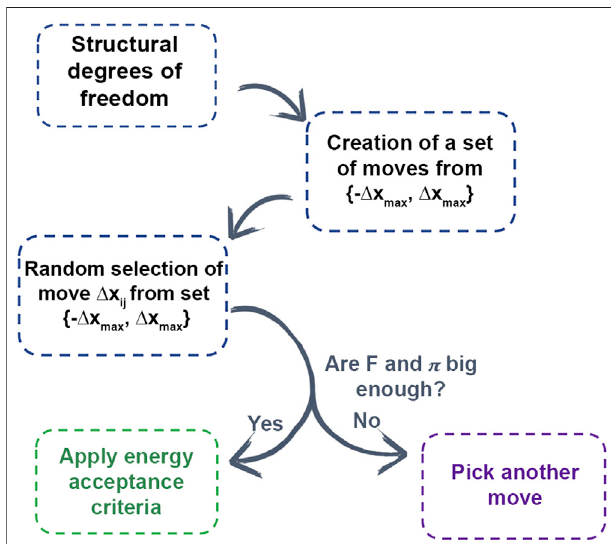
FIGURE 4 | Scheme of AROMOCA moves generation. Degrees of freedom are used to generate moves to create a set of moves in a speci fi c displacement. The moves are selected randomly from the set and if they obtain a high probability of acceptance and a high value of force, the energy acceptance criteria is